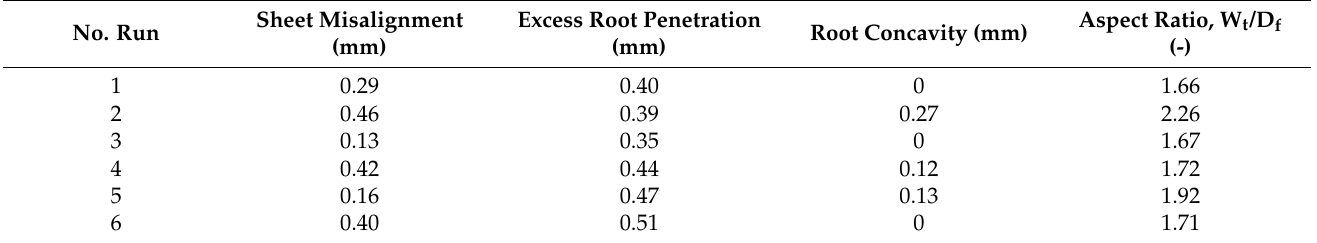
Table 3. Geometrical imperfections of the welded joints at varying welding conditions. W t : weld width at the top surface; D f : depth of the fusion